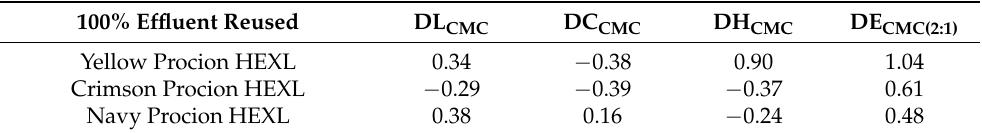
Table 5. Chromatic coordinates and color differences between fabrics dyed with the treated effluent and the reference